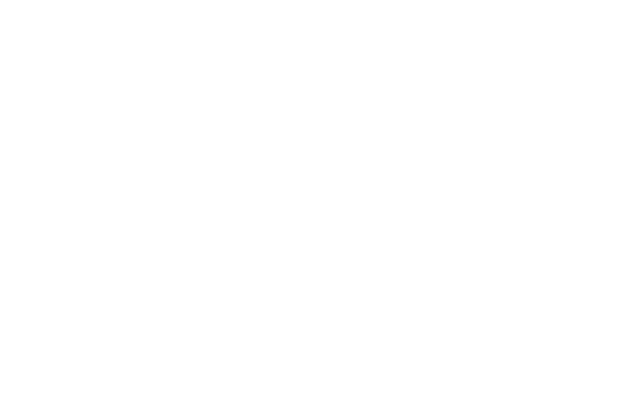
Figure 3. Analysis of gene flow. A maximum likelihood tree along migration events. Events relating to migration are represented as colored, weighted arrows. Parallel branch lengths are proportional to the degree of genetic drift that has appeared on each branch. The scale bar displays a standard deviation that is 10 times the mean of the values in the sample covariance matrix.